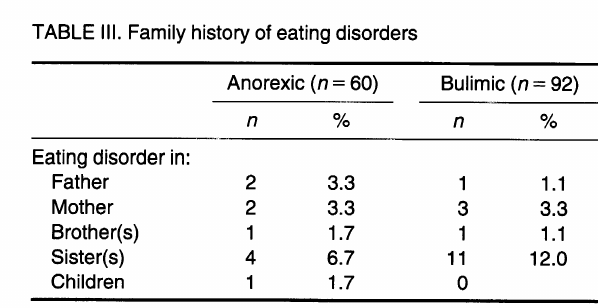
pared with 7.6% and 8.71% in the bulimic patients, respectively. The RA prevalence was, however, lower in both the anorexic (1.6%) and the bulimic patients (S.4%). The young age of the patients under study has to be con sidered as a limitation of the life-time prevalence. The onset of PU and ND was earlier in life for the bulimic patients (21.7 and 8.1 years) and later for the ano rexic patients (24.8 and 17.7 years, respectively). The onset of BA and RA was earlier for the anorexic patients (10.8 and 8.0 years) and later for the bulimic patients (16.8